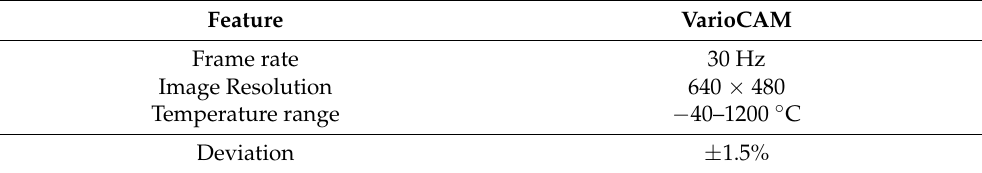
Table 2. IR camera